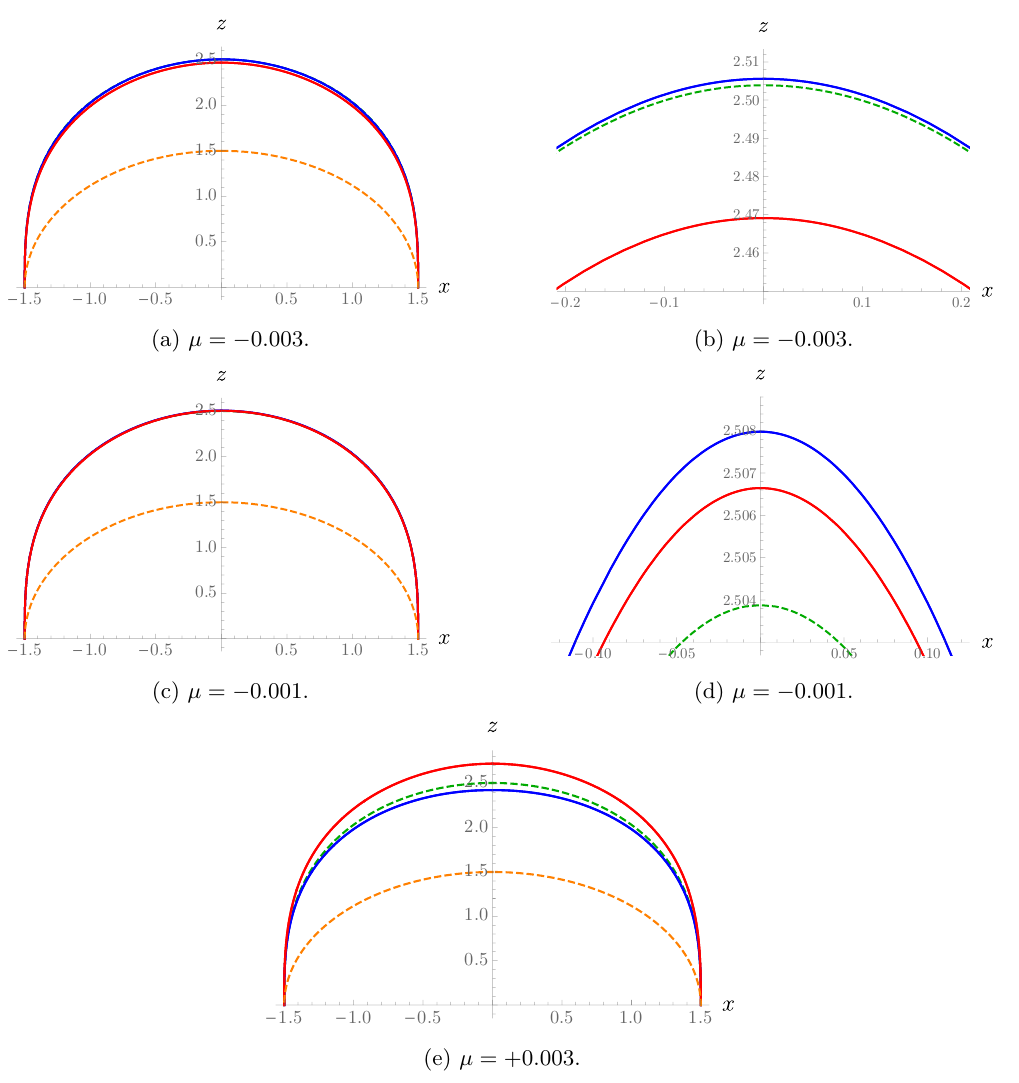
Figure 6 . Causal wedge (orange, dashed) and entanglement surfaces corresponding to ECG in the case of minimal prescription (blue), ECG in the case of non-minimal prescription (red), and Einstein gravity (green, dashed) [35] for the boundary strip length ‘/ 2 = 1 . 5 and different values of the coupling constant in the interval − 0 . 00322 ≤ µ ≤ 0 . 00312 . For negative values of µ , we include a close-up of the entanglement surfaces near x = 0 to tell them apart